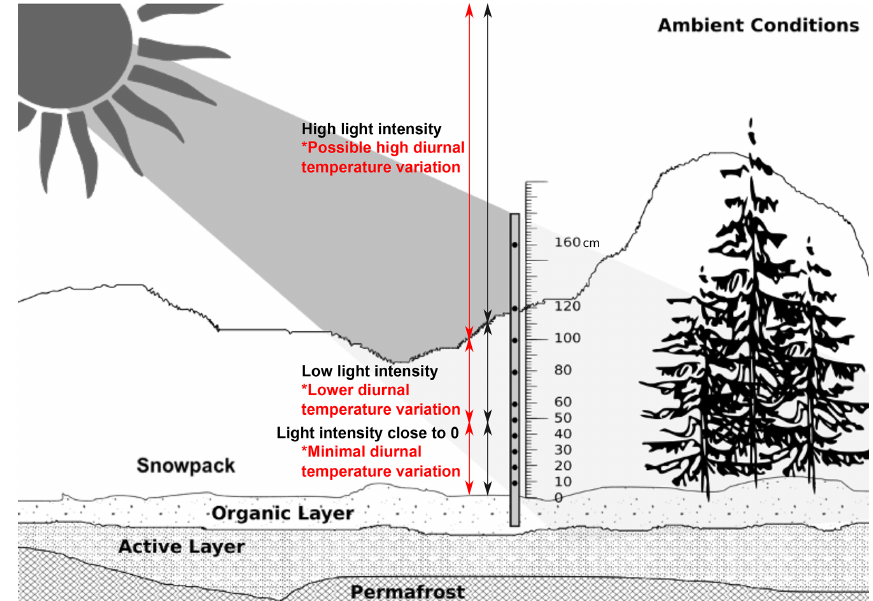
Figure 2. Conceptual diagram of the snow characterization with light and temperature (SCLT) method as implemented in this study. It is hypothesized that increases in snow depth will lead to sudden drops in light intensity measured by data loggers due to scattering and reflection in the snowpack (Perovich, 2007). A snow-covered logger is assumed to have mean values which are lower than ambient light intensity while temperature is assumed to remain at or just below freezing. Increased snow depth is assumed to result in less light penetration and decreasing diurnal temperature variation at lower logger heights. Impacts of snow ageing and density variations are expected to impact these processes but are not explored in the present analysis.